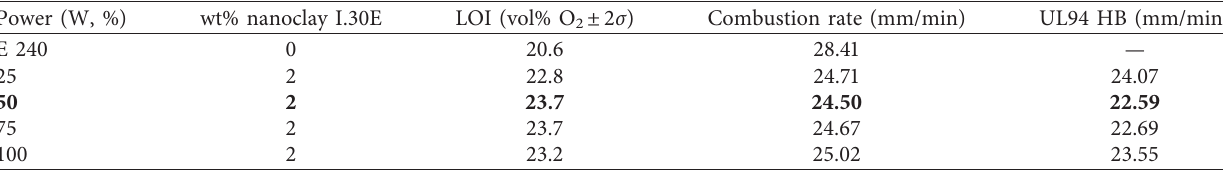
Table 10: Effect of ultrasonic stirring power on flame-retardant properties of epoxy Epikote 240/nanoclay I.30E nanocomposite material. Power (W,